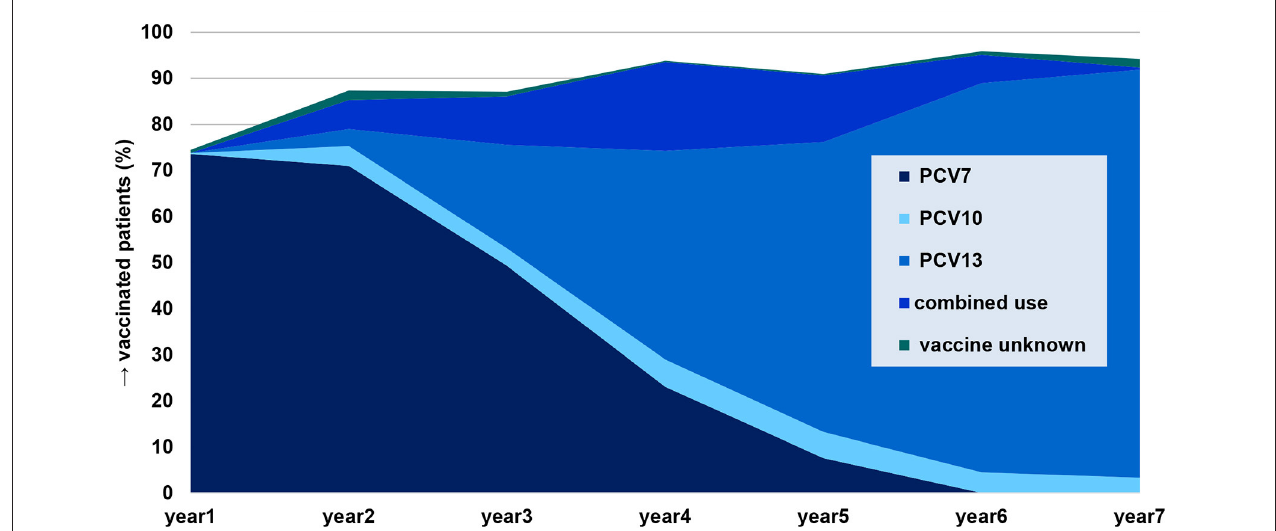
FIGURE 6 | Percentage of patients with severe spontaneously ruptured AOM vaccinated with at least one dose of a pneumococcal conjugate vaccine ( n = 1,884), categorized by vaccine type.